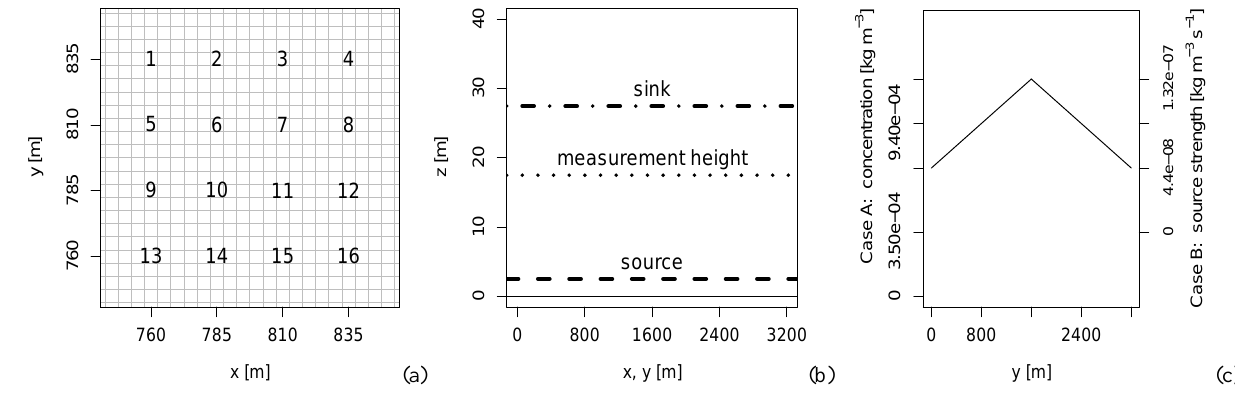
Fig. 3. Setup of Large Eddy Simulation study. Virtual sensor locations (a) , Source-sink distribution (b) and background concentration gradient (c) . Grid spacing: